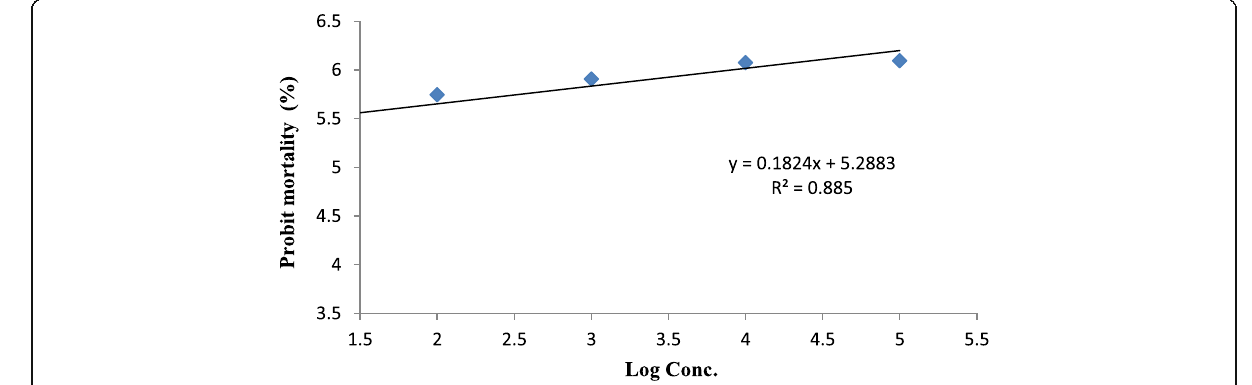
Fig. 5 Toxicity line of crude chitinase against Galleria